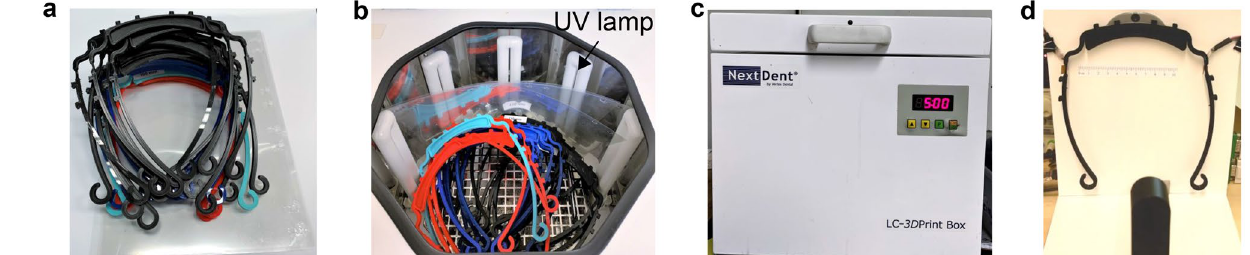
Figure 10. 3R process for customized visors. ( a ) Collect used visors and disassemble them to visor frames and transparent films. ( b ) Put the visor frames and transparent films in the UV light box. ( c ) Close the lid of the UV light box and perform UV disinfection for five minutes. ( d ) Repeat the customization process for reuse of the